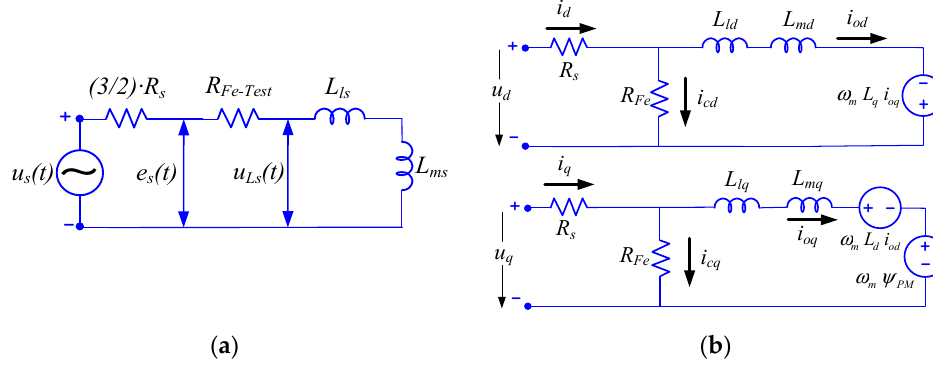
Figure 2. ( a ) Parameter estimation electrical model. ( b ) d-q electrical